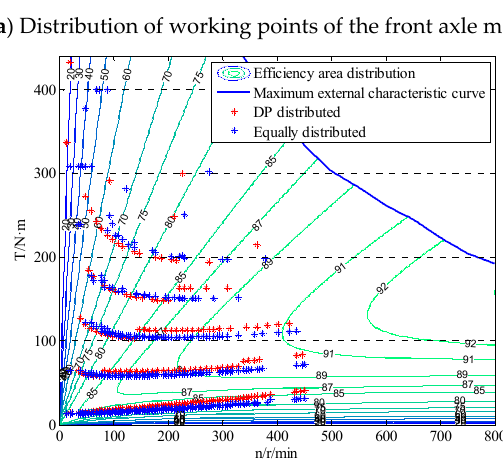
Figure 15. Motor efficiency distribution in HUPDC. 5.3. Energy Consumption Analysis of Electric Drive System Under two different control strategies, the 100 km power consumption of the all-wheel drive power system is compared as shown in Figure 16. As a result of the optimization of the working point of the shaft motor, when the simulation prototype vehicle adopted the DP global optimization torque distribution strategy under China urban passenger cars driving cycle, the 100-kilometer energy consumption of the electric drive system was 12.585 kWh, which was reduced by 0.75 kWh compared to the average allocation rule. Under the HUPDC, when adopting the DP global optimization torque distribution strategy, the energy consumption of 100 km of electric drive system is 10.338 kWh, which is 0.588 kWh lower than that based on the average allocation rule.